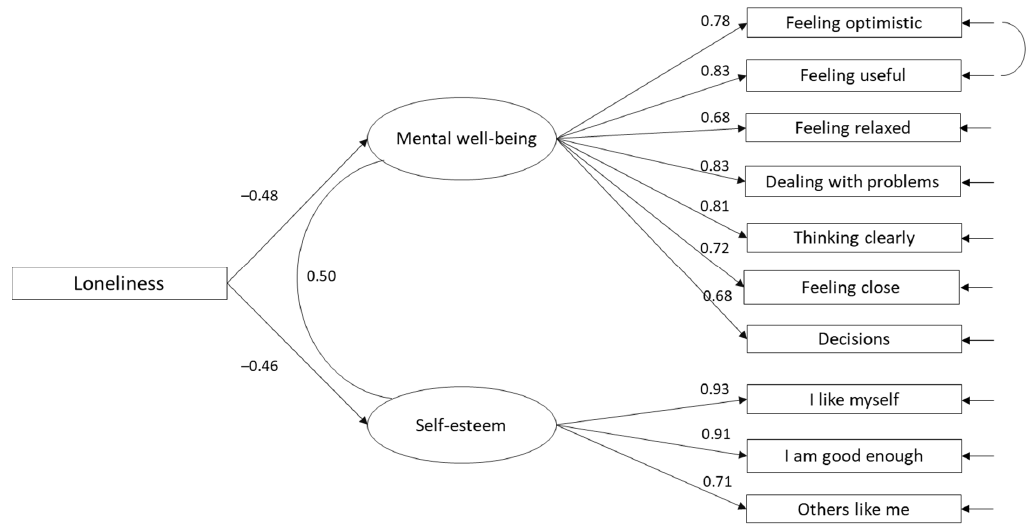
Figure 1. Perceived loneliness as a predictor for low mental well-being and low self-esteem ( n = 5751). Standardized beta coefficient reported. All estimated parameters were statistically significant at level p < 0.001.